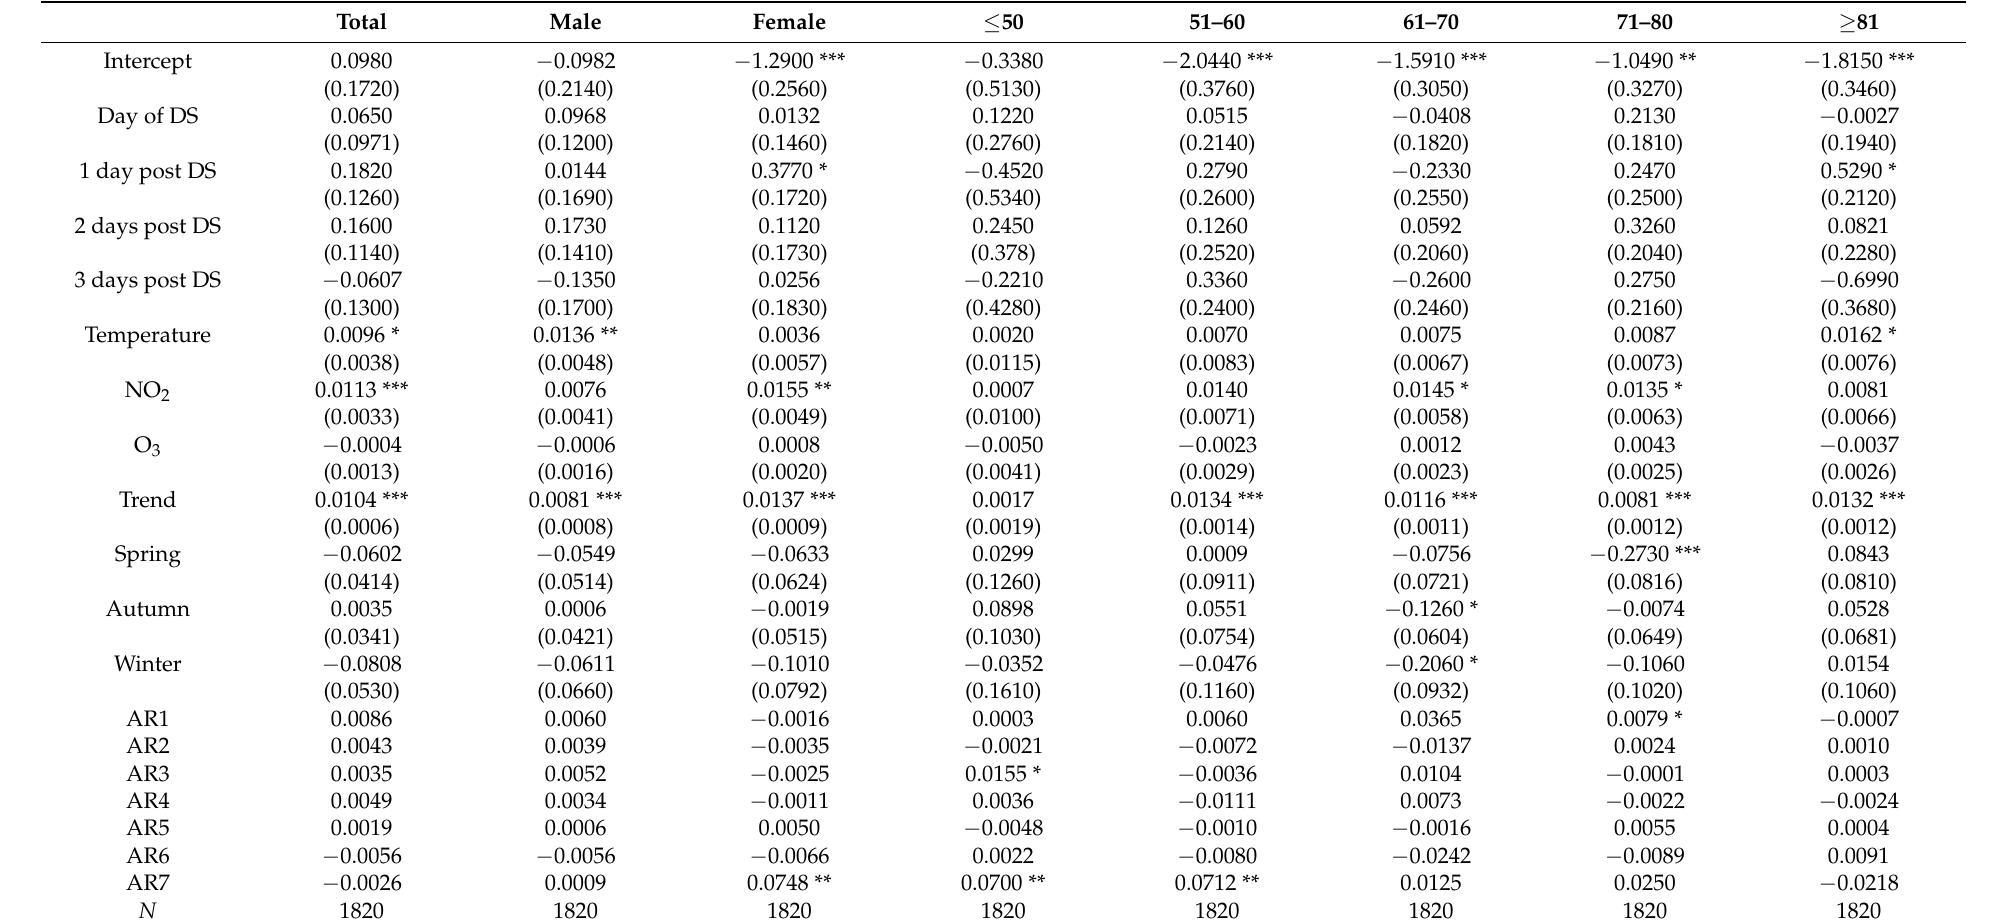
Table 3. Poisson autoregressive analysis for wet AMD outpatient